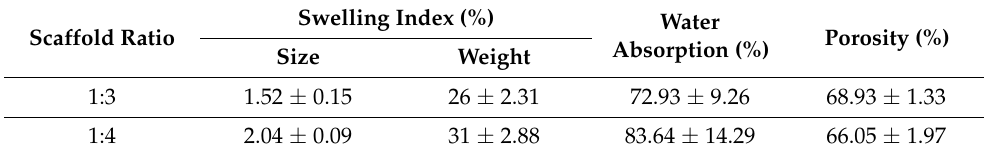
Porosity (%) Absorption (%)